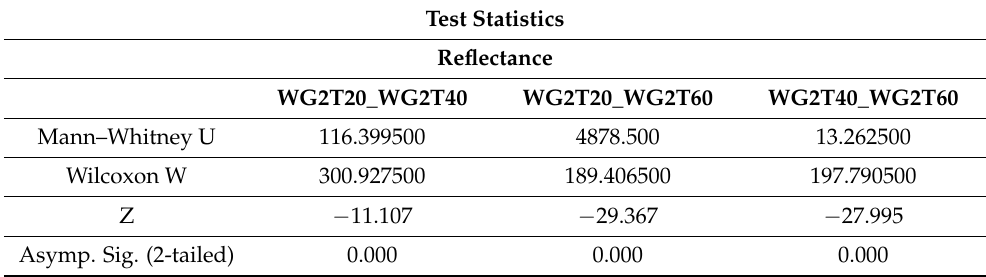
Table A18. Tests statistics table of Mann–Whitney U test for specular solar reflectance of WG2 during the three holding times.